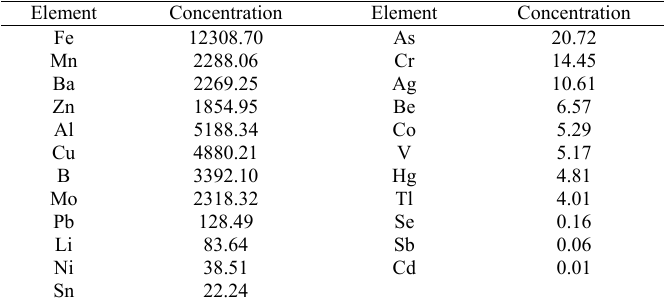
Se 83.64 Sb 0.06 Ni 38.51 Cd 0.01 Sn 22.24